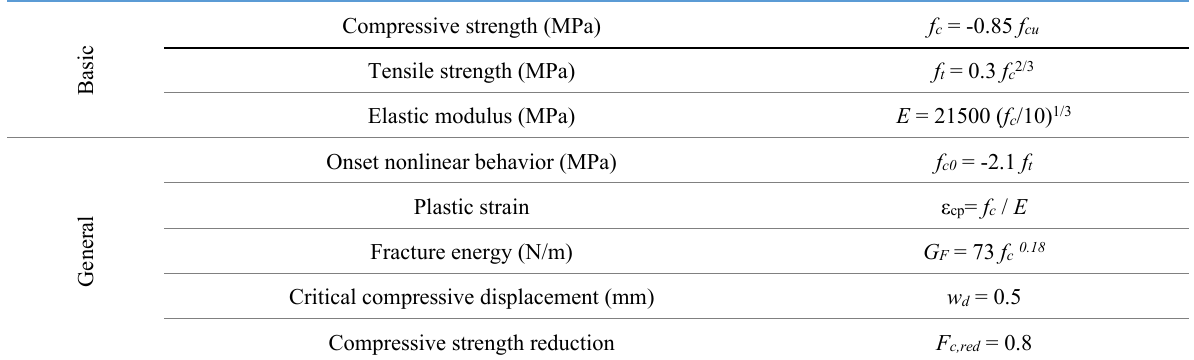
Table 1. Constitutive relation of the concrete